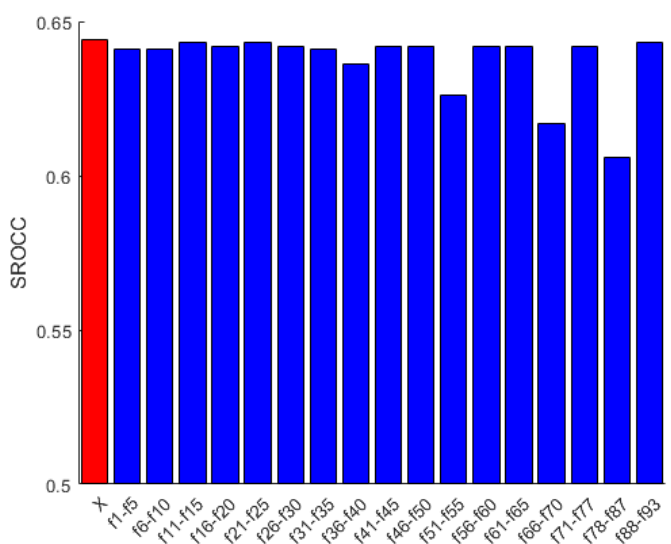
Figure 4. Performance in terms of SROCC of the proposed FLG-IQA in cases when a given feature is removed from the proposed feature vector. The performance of the entire feature vector is indicated by ’X’. Median SROCC values were measured on CLIVE [45] after 100 random train–test splits.